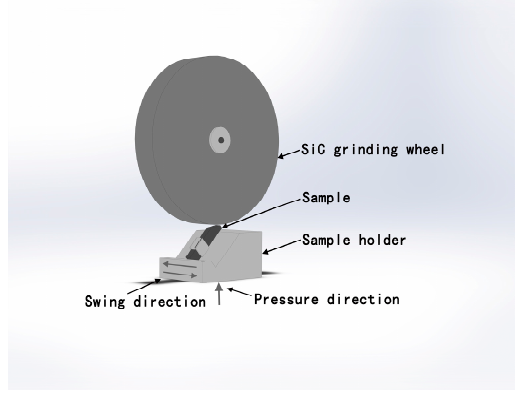
Figure 1. Schematic diagram of the grinding ratio test.